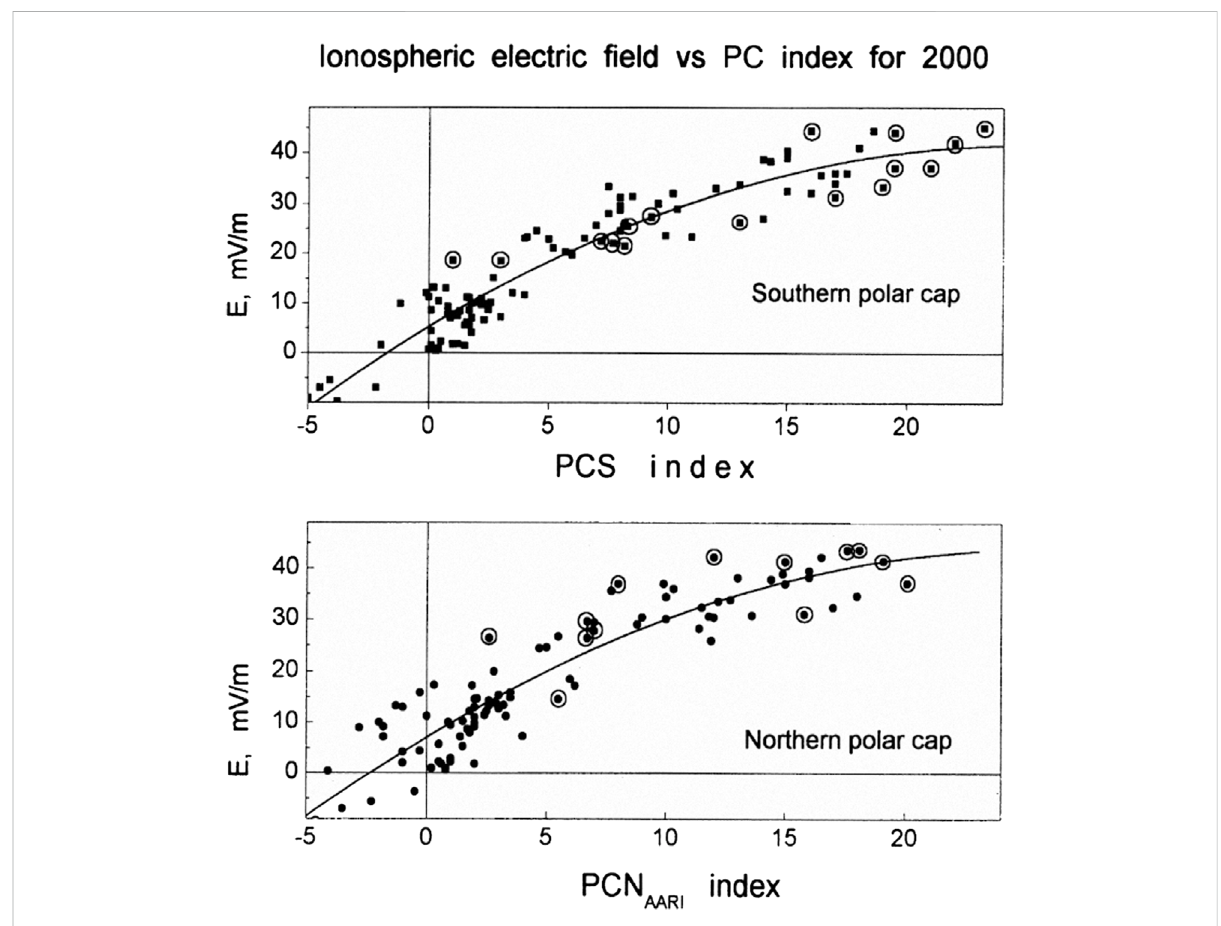
FIGURE 12 Relationbetween PC indexandionosphericelectric fi eldmeasuredbyDMSPspacecraft(h=840 km)underconditionsofhighmagneticactivity (Troshichev et al., 2000). Measurements during the days with powerful polar cap absorption are marked by points within the